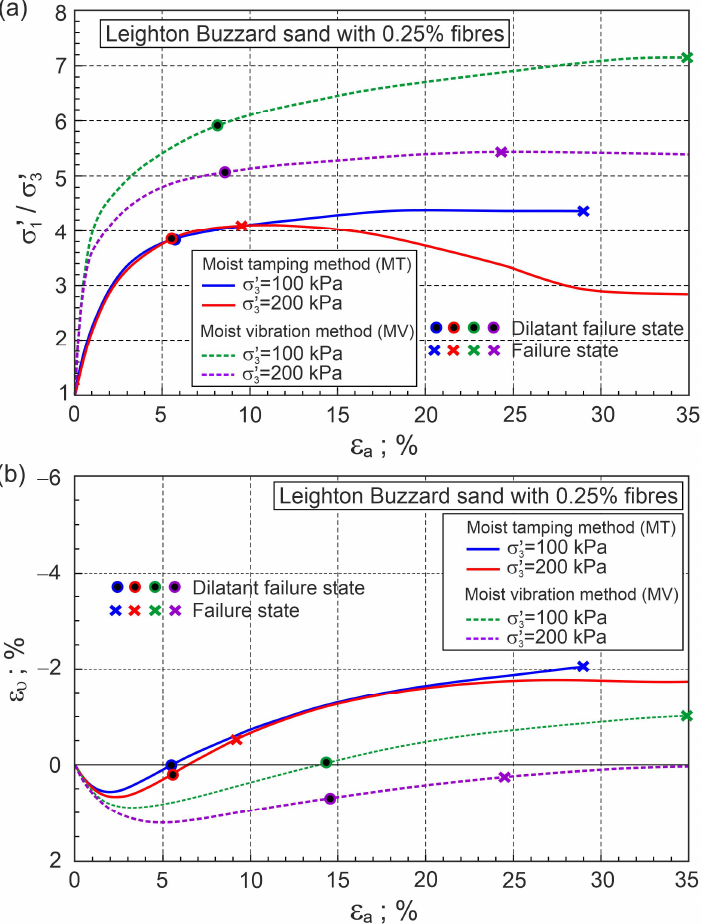
− ε a and ( b ) / σ (cid:48) 3 1